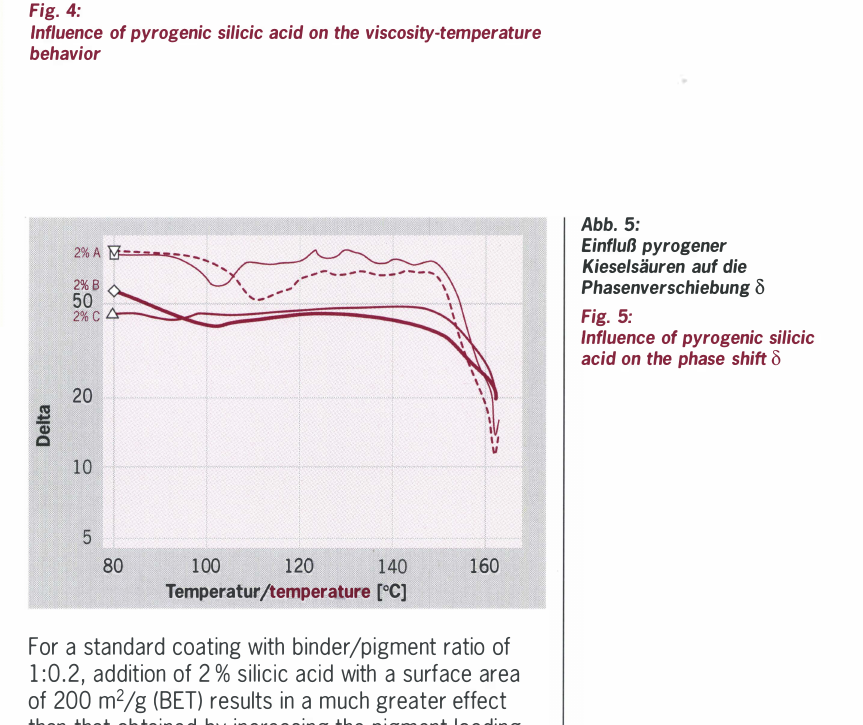
For a standard coating with binder/pigment ratio of 1 :0.2, addition of 2 % silicic acid with a surface area of 200 m2/g (BET) results in a much greater effect than that obtained by increasing the pigment loading by a factor of four. In addition, increasing the solids loading to this level causes practical problems in processing and significant reductions in the optical quality of the product.